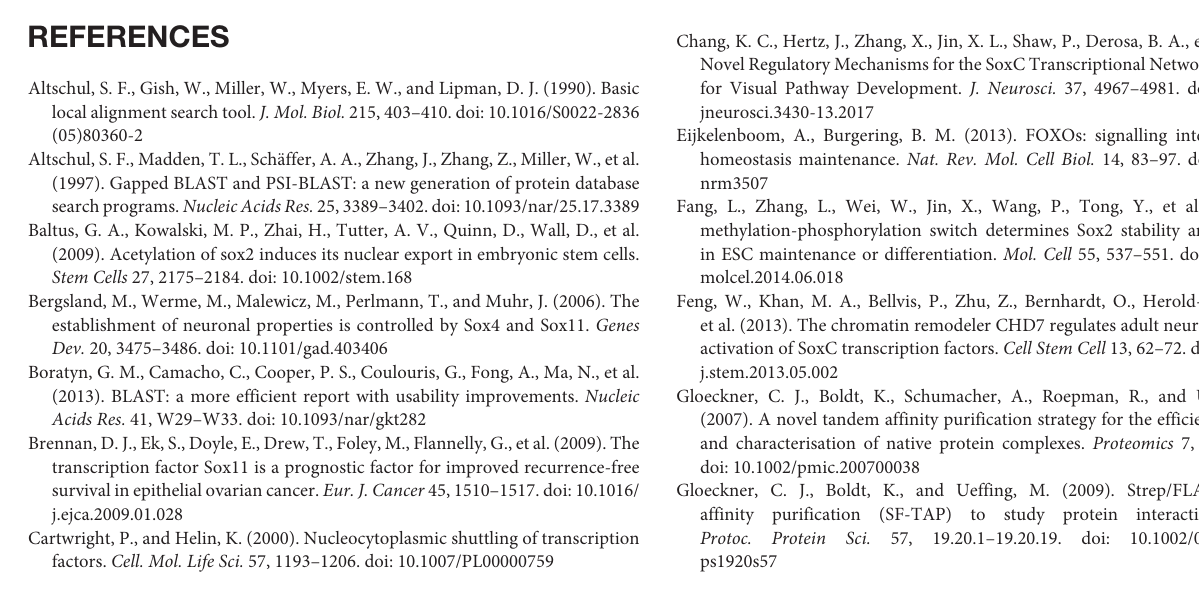
FIGURE S3 | (A) Experimental work flow for the generation of Phospho Stop and lambda phosphatase treated nuclear and cytoplasmic extracts from embryonic mouse brains. (B–G) Full blots from Figure 3A . The antibody used for blotting is listed below the blot.